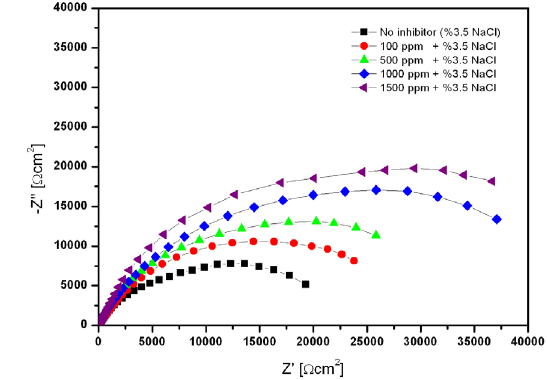
Figure 3. Nyquist plots for Al-2007 alloy in 3.5% NaCl media in the absence and presence of different concentrations of mad honey.